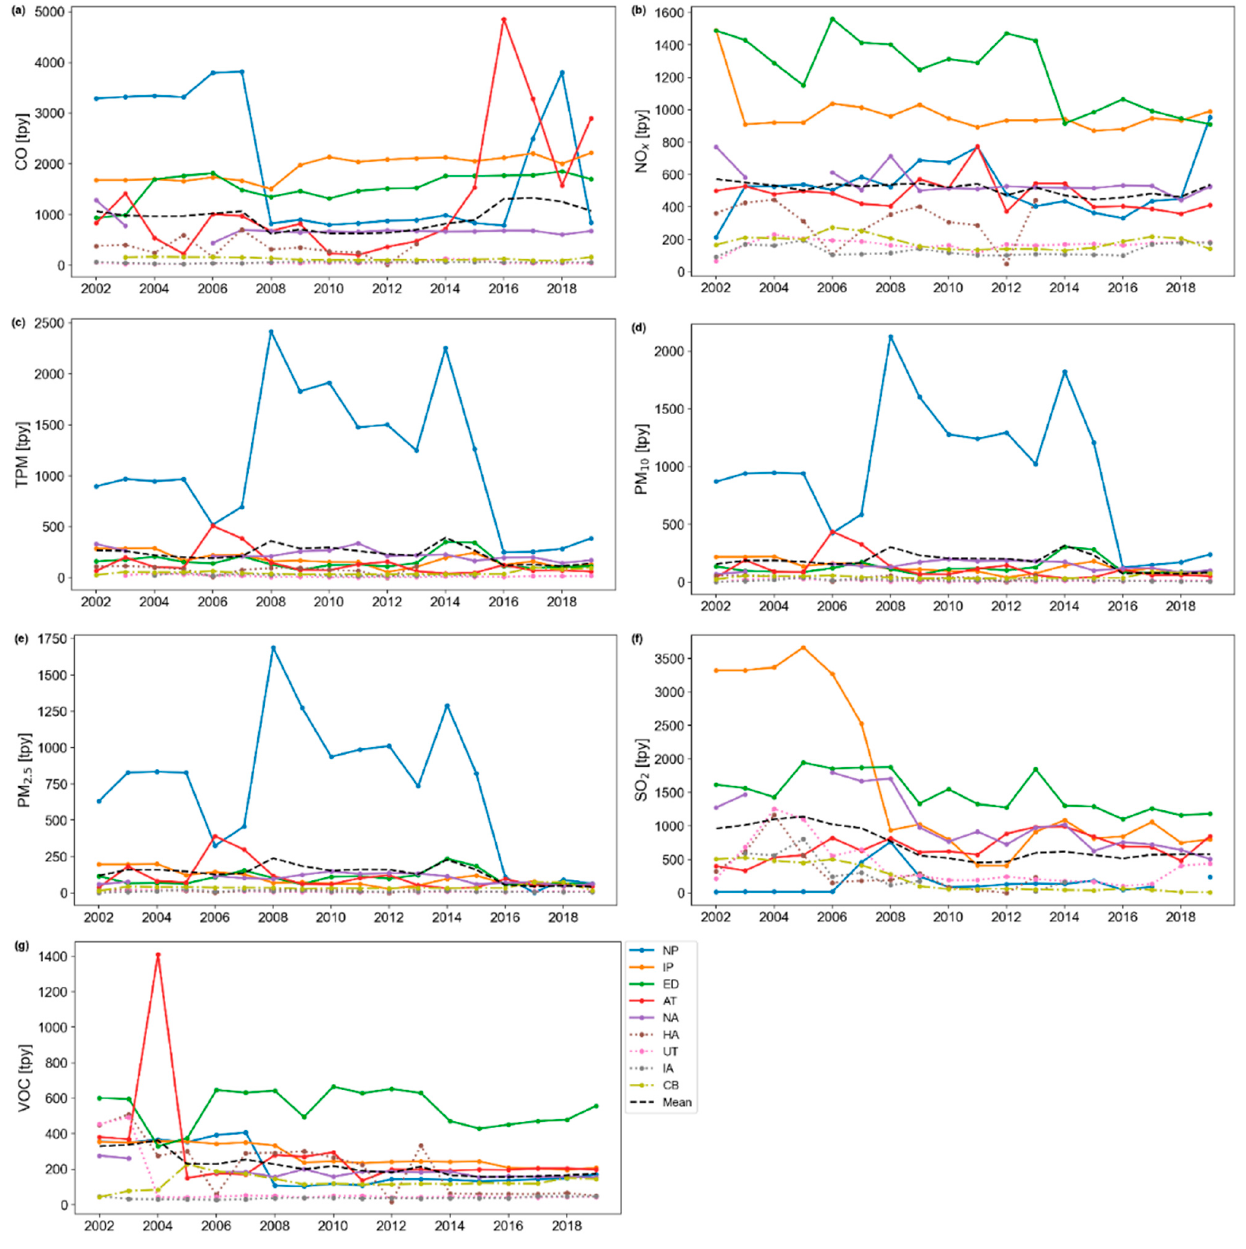
Figure 3. Air pollutant emissions from 2002 to 2019 for each facility for pollutants ( a ) CO, ( b ) NO x , ( c ) TPM, ( d ) PM 10 , ( e ) PM 2.5 , ( f ) SO 2 , and ( g ) VOC.